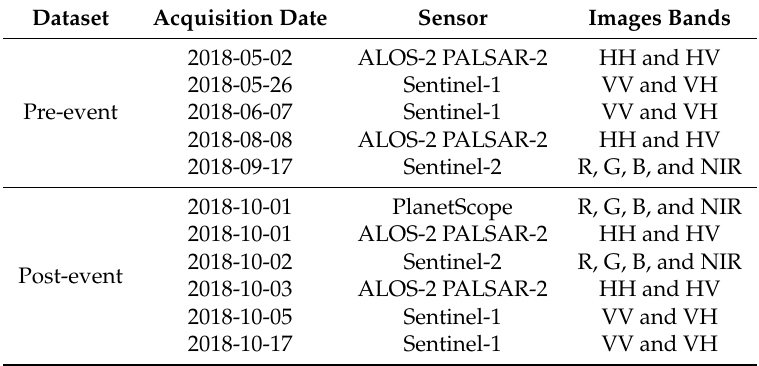
Table 1. Description of the remote sensing data used in this